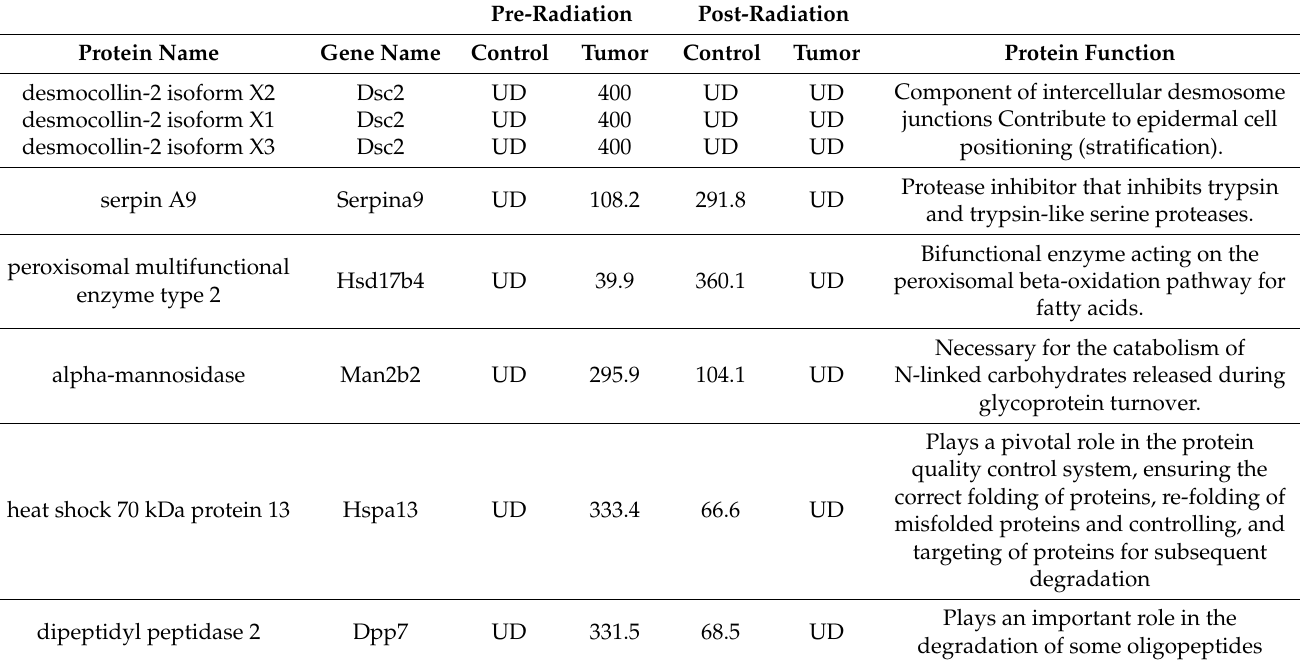
Table 1. Protein expression values in salivary exosomes pre and post radiation